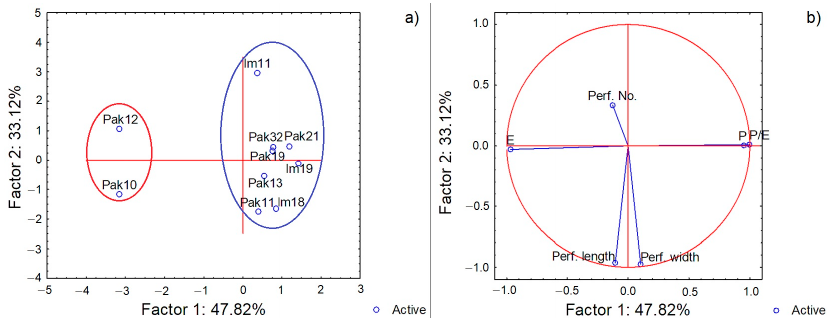
Figure 3. Two-step PCA representation of V. sylvestris genotypes: ( a ) Projection of points approx- imate the differences between samples. Nearby points represent samples with similar patterns, i.e., male individuals with 3-colporate pollen are grouped to the right in the plot (blue circle); female individuals with inaperturate pollen are grouped to the left in the plot (red circle). ( b ) Vectors approximate phenotypic trait. Highly correlated traits point in roughly the same direction. The longer the arrow, the stronger the correlation. The polar axis (P) and P/E ratio have strong positive correlation opposite to equatorial axis (E) length, with strong negative correlation toward P and P/E. Grouping of male individuals is mainly explained by P and P/E, and female individuals were negatively correlated with male individuals, being differentiated mainly by pollen width (E).